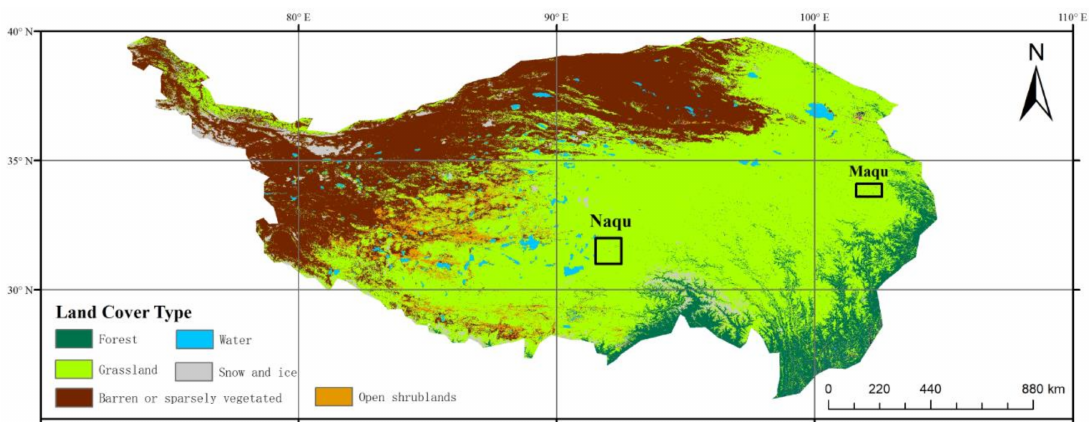
Figure 1. The locations of the two soil moisture and temperature monitoring networks used in this study (denoted as two small black rectangles on the Tibetan Plateau). The distribution of land cover on the Tibetan Plateau is shown for context. Land cover is based on MODIS (Moderate Resolution Imaging Spectroradiometer), with classifications drawn from IGBP (International Geosphere-Biosphere Programme) land cover